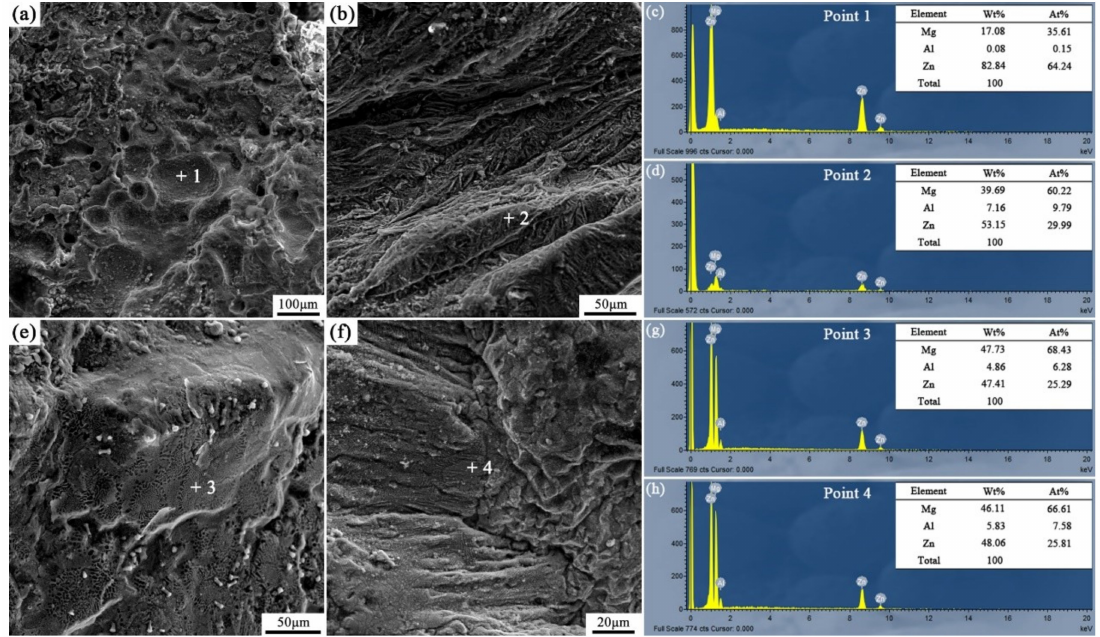
Figure 17. Fracture analysis of the arc-sprayed Al / AZ91D bimetals with a Zn interlayer: ( a , b ) SEM micrographs of S30H6 fracture surfaces, ( c , d ) EDS point scan spectra of points “1” and “2” ( e , f ) SEM micrographs of S30H12 fracture surfaces, ( g , h ) EDS point scan spectra of points “3” and